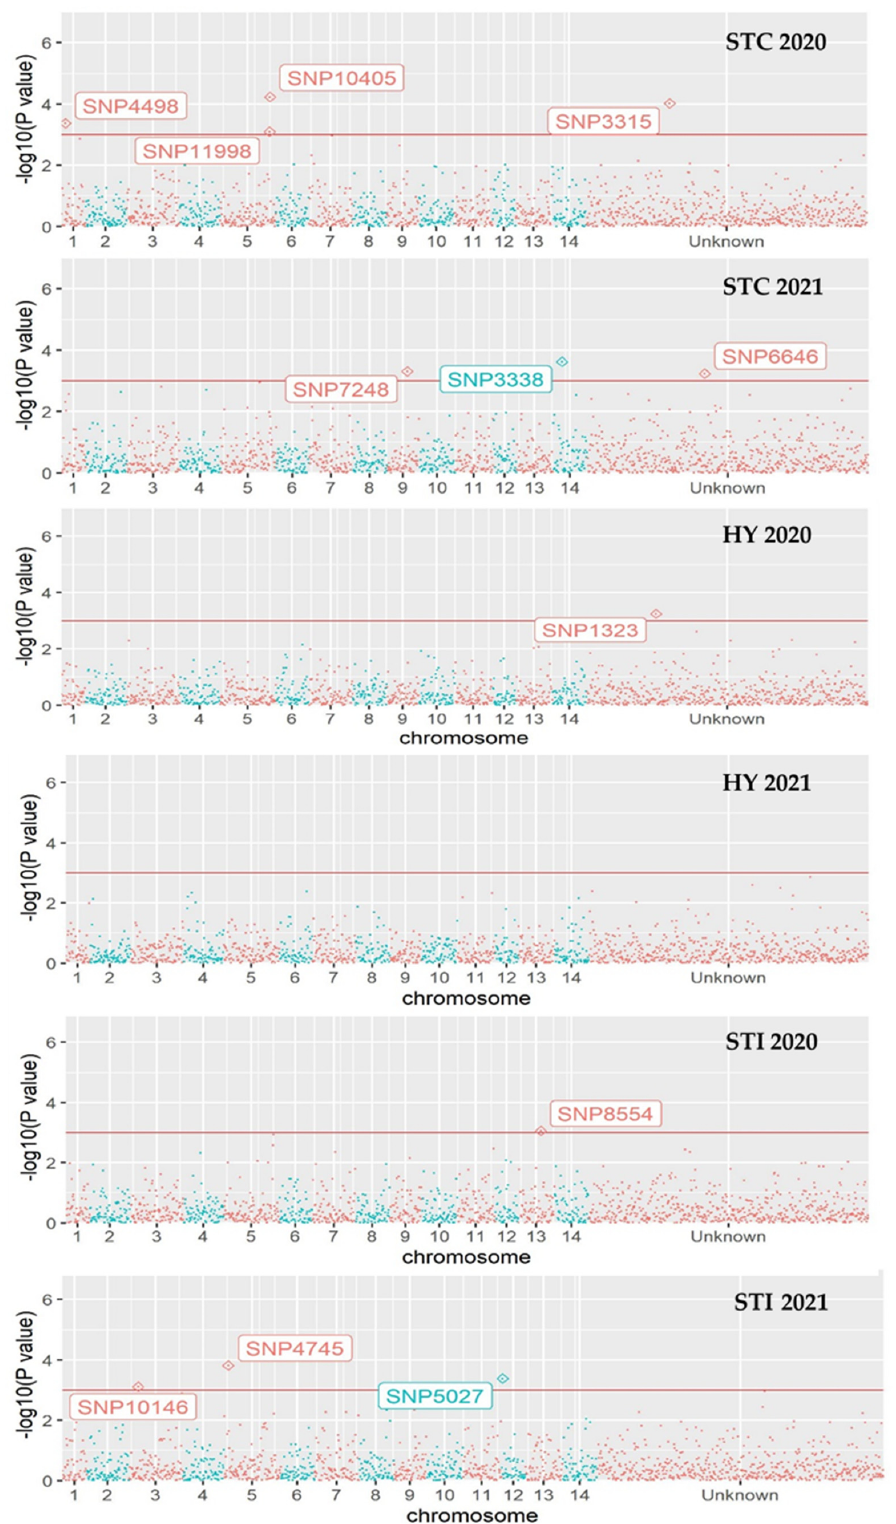
Figure 4. Manhattan plots showing distribution of SNPs across the macadamia genome and significance of marker–trait associations for three traits in 2020 and 2021 in the M. tetraphylla panel. STC = log e (count of stick-tights), HY = log e (harvestable yield (count of nuts)), STI = logit(stick-tight incidence (STC/(STC + HY)).